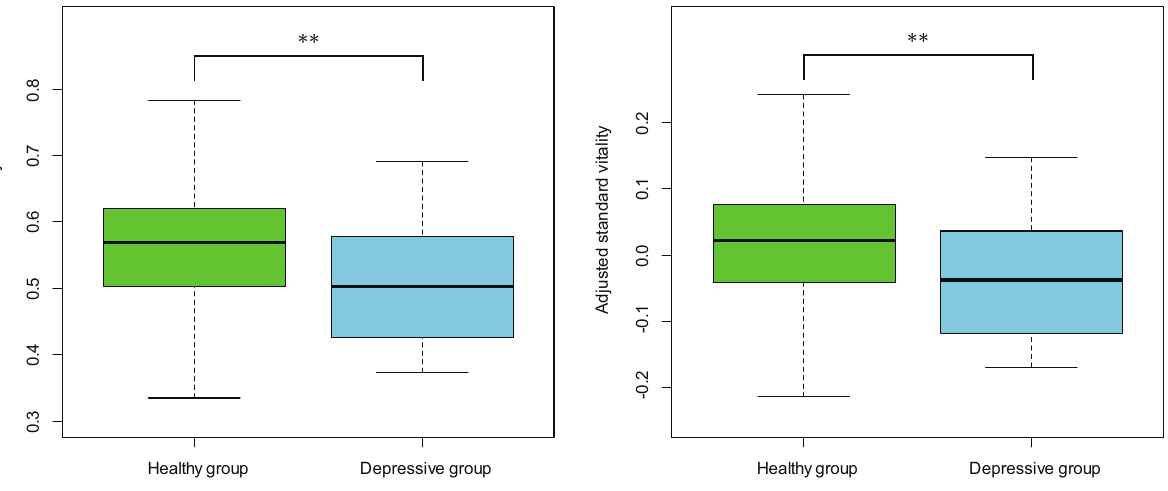
Figure 4. Box plots of the standard and adjusted standard vitality distributions for the healthy and depressive groups.